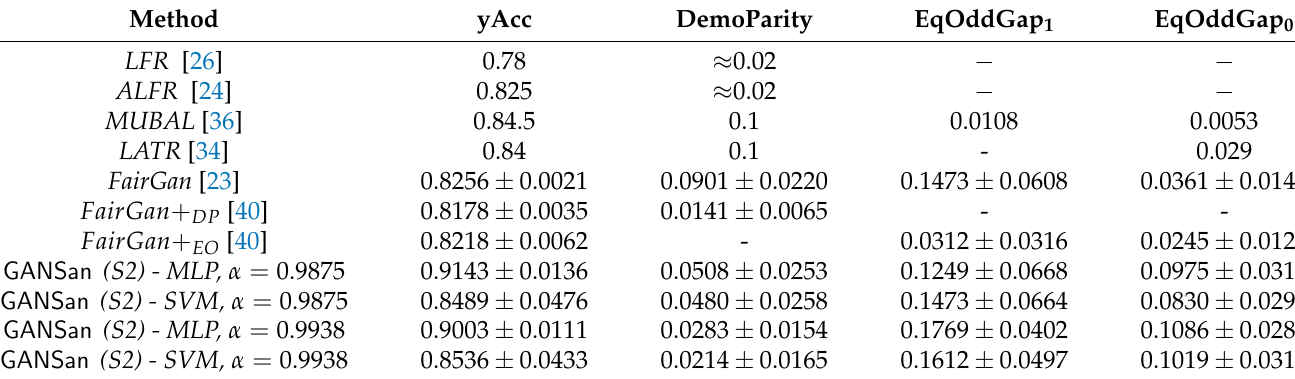
Table 5. Comparison on the basis of accuracy and demographic parity on